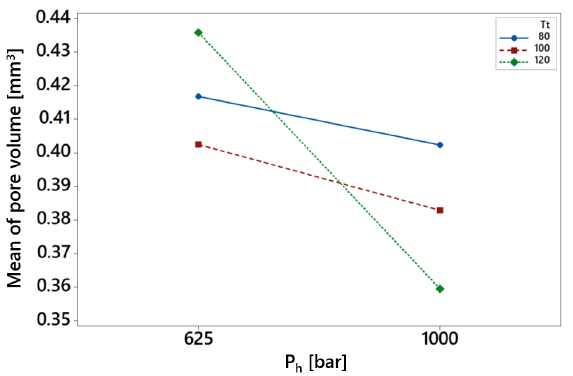
Figure 9. Interaction plot between mold temperature and packing pressure for pore